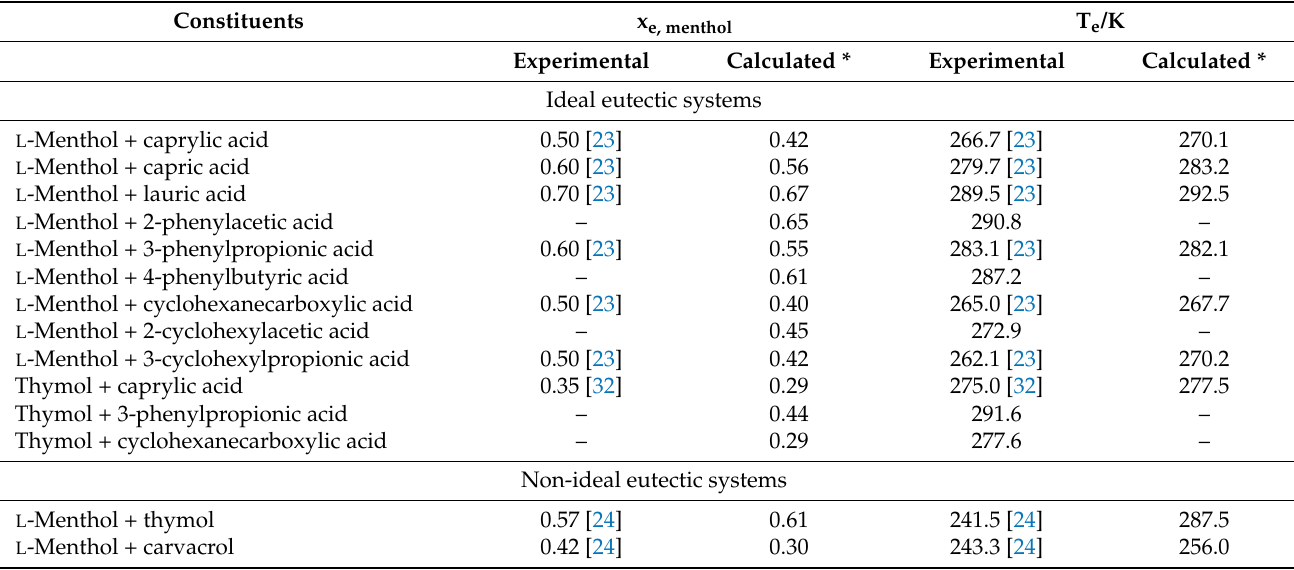
Table 2. Eutectic systems studied in this work classified according to the behavior of components in the liquid phase along with their experimental and calculated eutectic composition (x e ) and eutectic temperature (T e ) assuming ideal solution